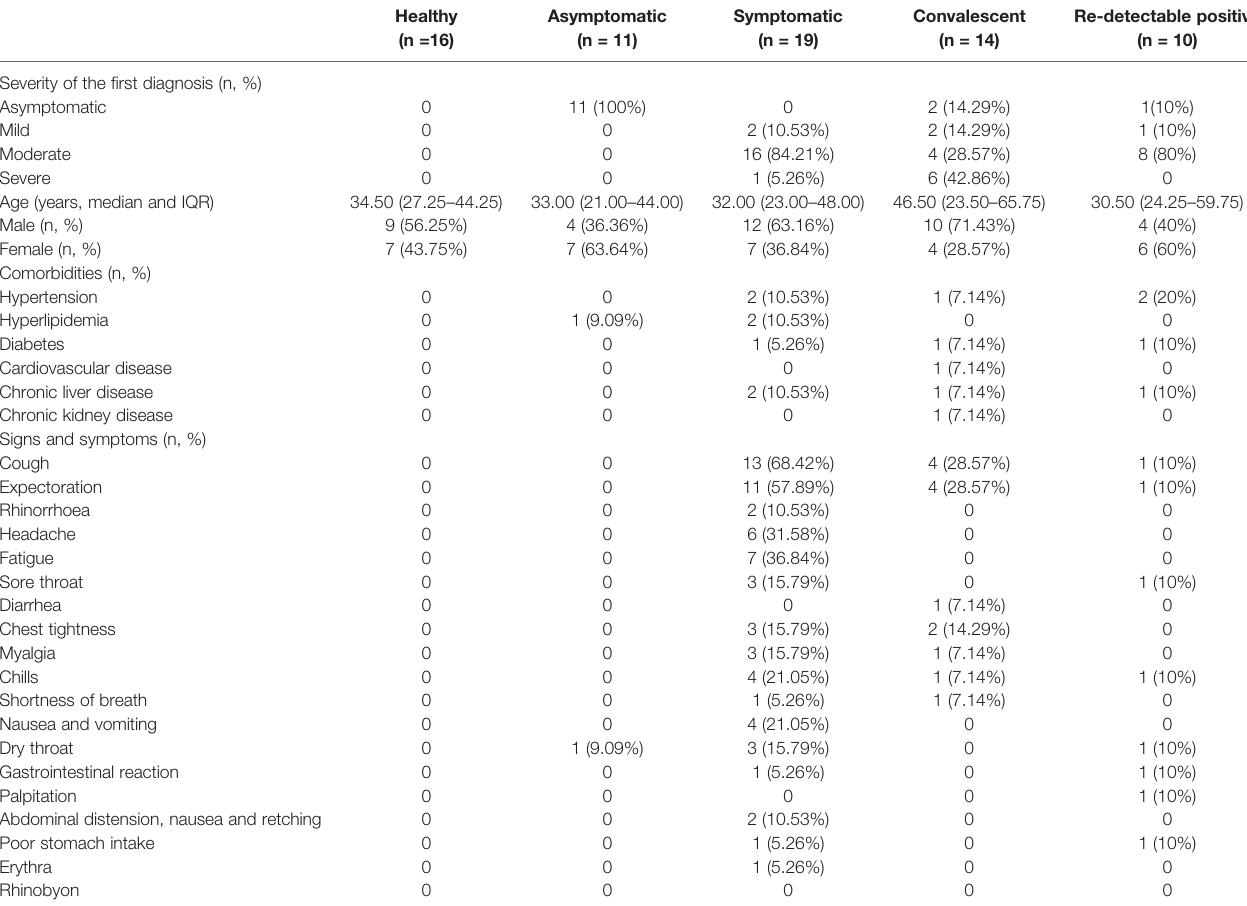
TABLE 1 | Baseline characteristics of study